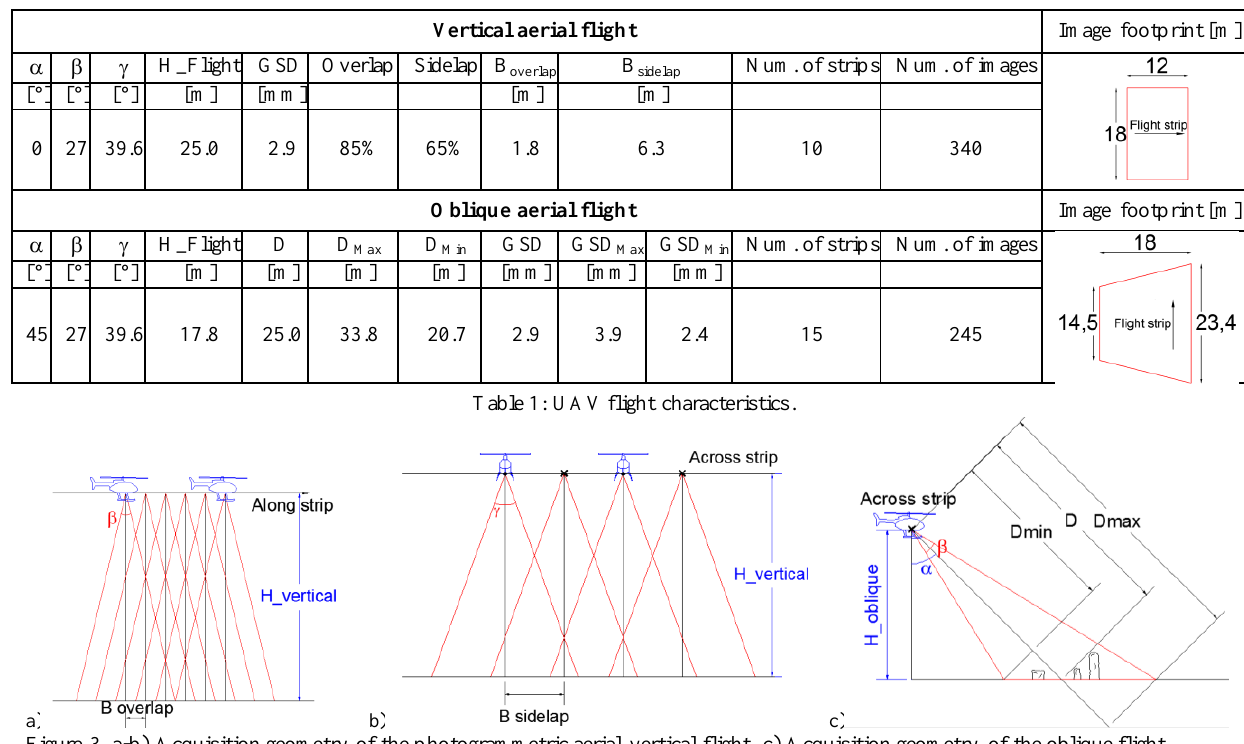
Table 1: UAV flight characteristics.